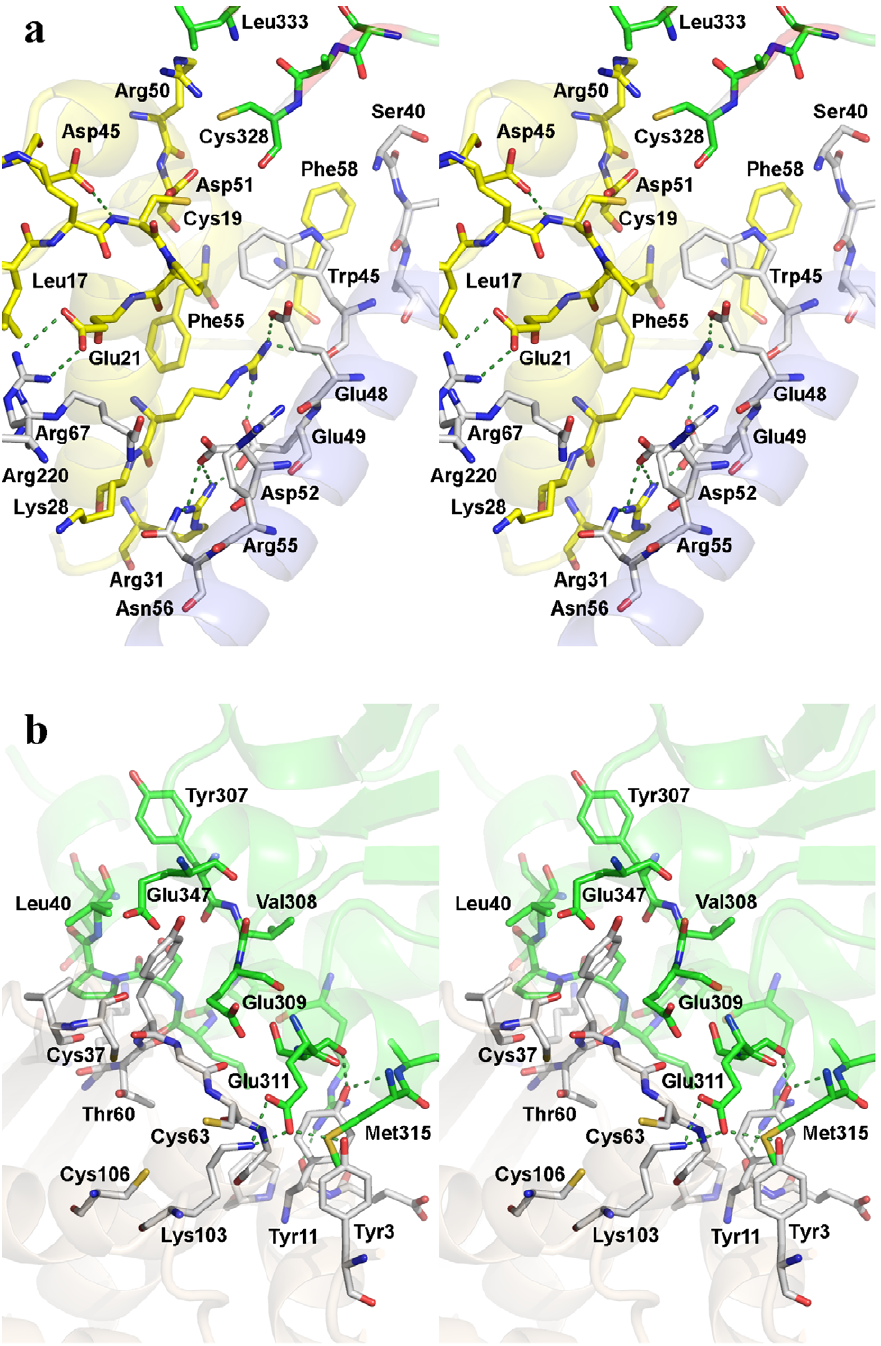
Figure 3. Interface between IscS and TusA or IscU. (A) IscS-TusA, IscS (gray carbons), and TusA (yellow carbons). The Cys328 IscS and Leu333 IscS from the second subunit are shown with green carbons. The IscS residues in between are disordered. The conserved Asp45 TusA and Asp51 TusA are shown explicitly in stick mode. Hydrogen bonds are marked as dashed lines. Salt bridges Arg27 TusA …Glu49 IscS …Arg31 TusA …Asp52 IscS in the center of the interface and Glu21 TusA …Arg220 IscS at the periphery are explicitly shown; (B) IscS-IscU: IscU, gray carbons. The residues displayed are within 3.7 A˚ of its binding partner.